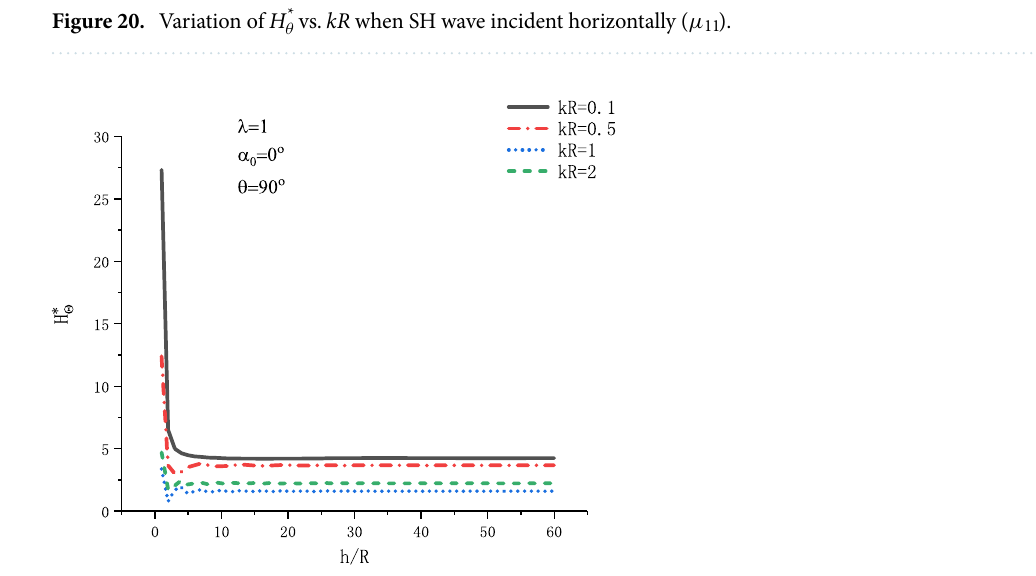
* h R when SH wave incident θ vs. (cid:31)